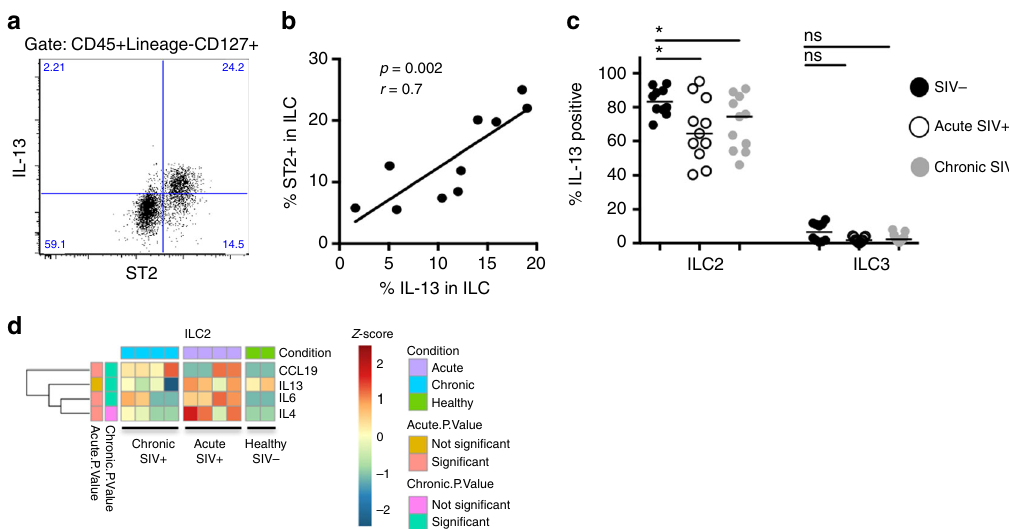
Fig. 4 IL-13 production is impaired in ILC2 cells in MLNs that are marked by ST2 expression. a Plot of ST2 expression in total ILC compartment against IL-13 production in total ILC compartment. b Correlation between ST2 + ILCs and IL-13-producing ILCs in a cohort of uninfected animals. c Mes LNMCs from healthy, acute, or chronically SIV-infected animals were stimulated for 6 h with PMA/ionomycin. Intracellular IL-13 expression was measured in ILC1, ILC2, and ILC3 subtypes. d Gene expression pro fi les of cytokines produced by ILC2. Color scheme in both heatmaps represents the number of standard deviations above (red) or below (blue) the mean. Statistical signi fi cance was determined by the Mann – Whitney test. A Spearmann's correlation was calculated for panel b . ns = P > 0.05, * = P ≤ 0.05, ** = P ≤ 0.01, *** = P ≤ 0.001, and **** = P ≤